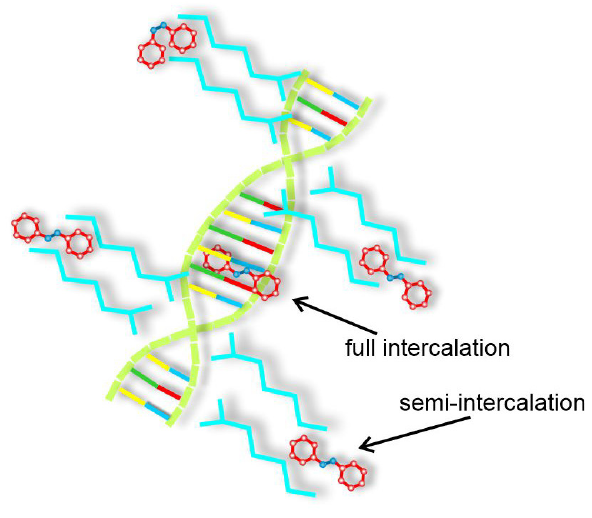
Figure 21. Scheme of semi-intercalation and full intercalation of an azo-dye molecule in DNA-CTMA